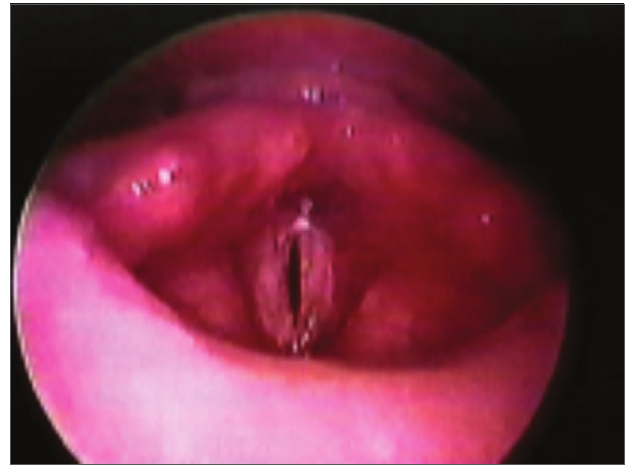
Figure 1. Posterior glottic stenosis grade The submucosal scar is easily vaporized by CO laser (0.25 2 mm microspot, superpulse mode, 5 watts). The mucous flap is thinned and placed over the open surface on one side and fixed with fibrin gel on the site (Tissucol ® ). This is the unilateral microtrapdoor flap technique. Subtotal arytenoidectomy associated with the mi- crotrapdoor flap was done in five patients (29.4%) with